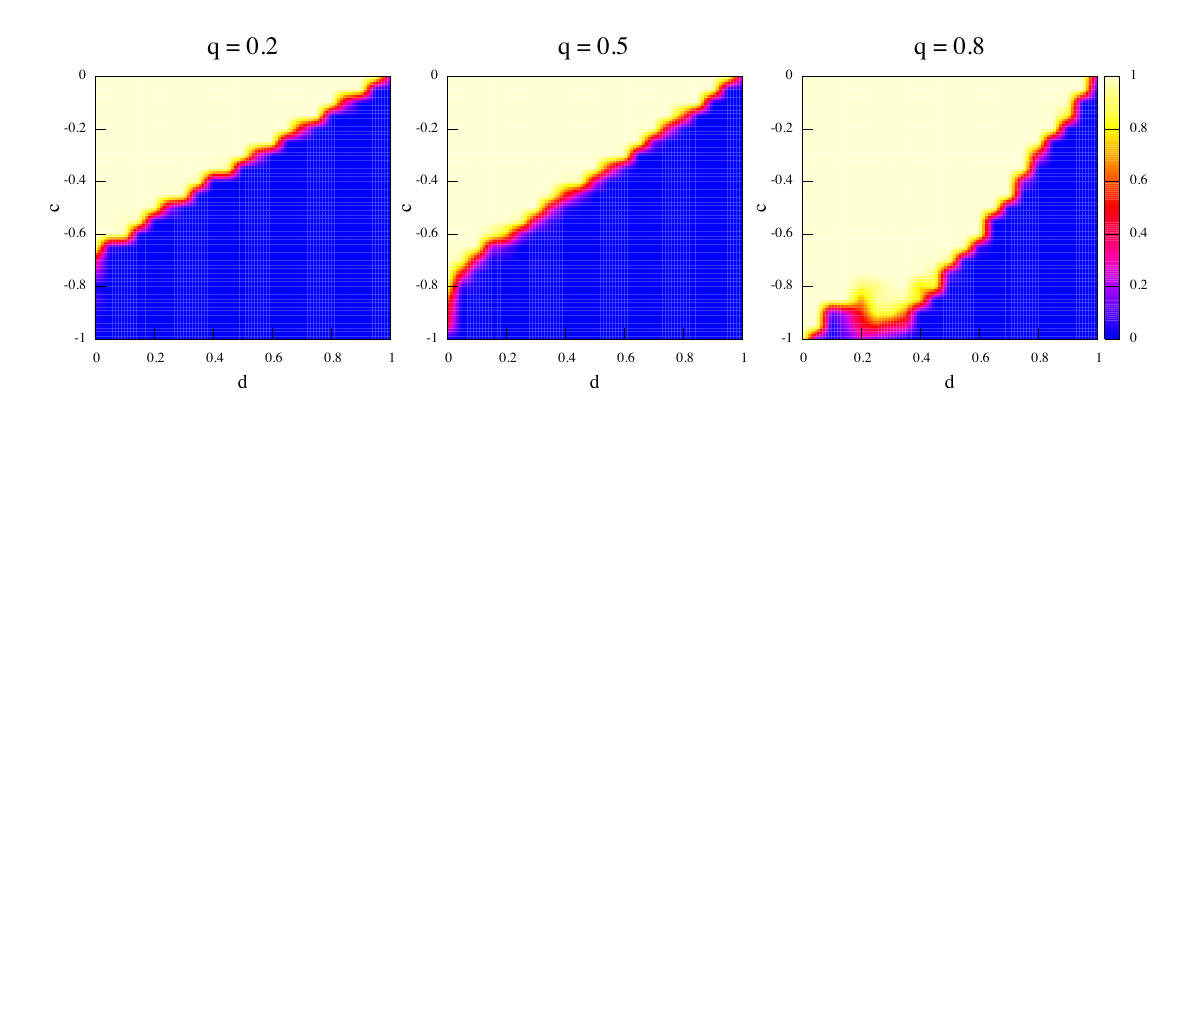
Figure 8. Average strategy proportions over 50 independent runs in the game’s phase space at steady state. Initially α players are 25% of the total. Update rule is best response and rewiring frequency q increases from left to